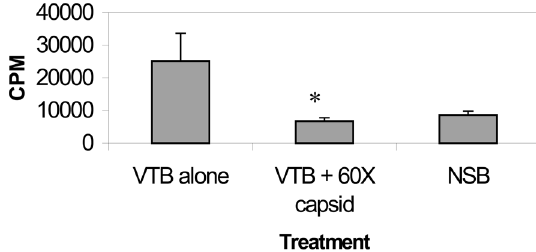
Figure 4 Effect of excess unlabeled B19 VP2 empty capsid on binding of I 125 -labeled B19 VP2 empty capsid to VTB. I 125 -labeled B19 VP2 empty capsid (750 ng) was added to 2.5 6 10 4 VTB (VTB alone), and this binding was competed for using 60-fold excess unlabeled B19 VP2 empty capsid (VTB + 60X capsid). Differences between the calculated means of VTB alone and that of the 60-fold excess unlabeled capsid competition experi- ment were statistically different ( p 5 0.01). Error bars represent the standard deviation of the